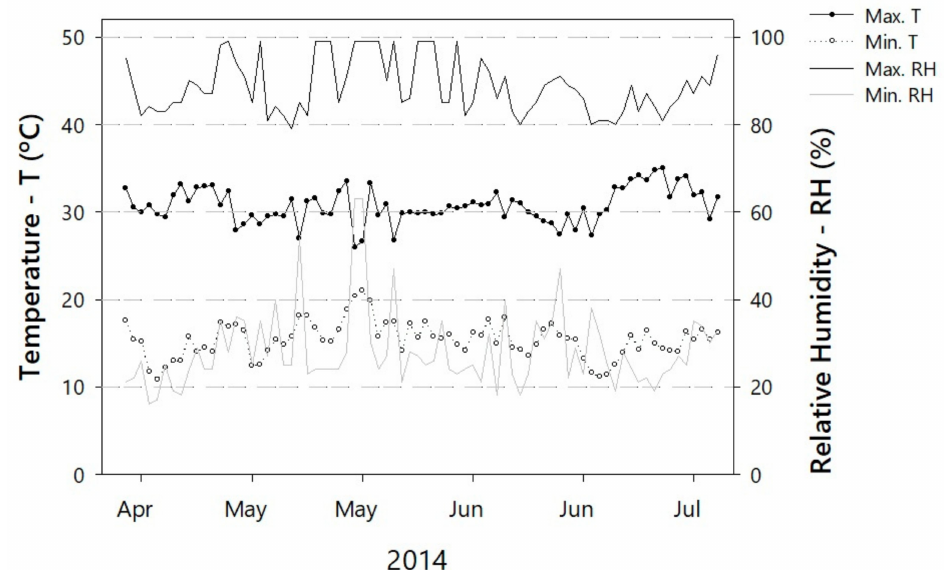
Figure 1. Daily maximum and minimum temperatures and relative humidities as measured inside the greenhouse where nuclear seed potatoes were grown under aeroponics from April to July